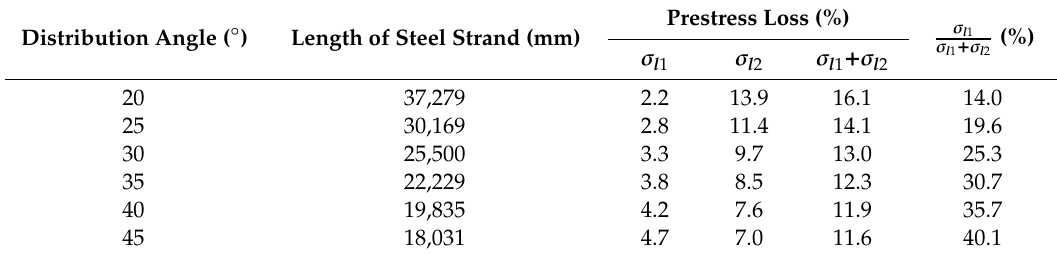
Table 11. Theoretical prestress loss of steel strands given the slab width of 12.75